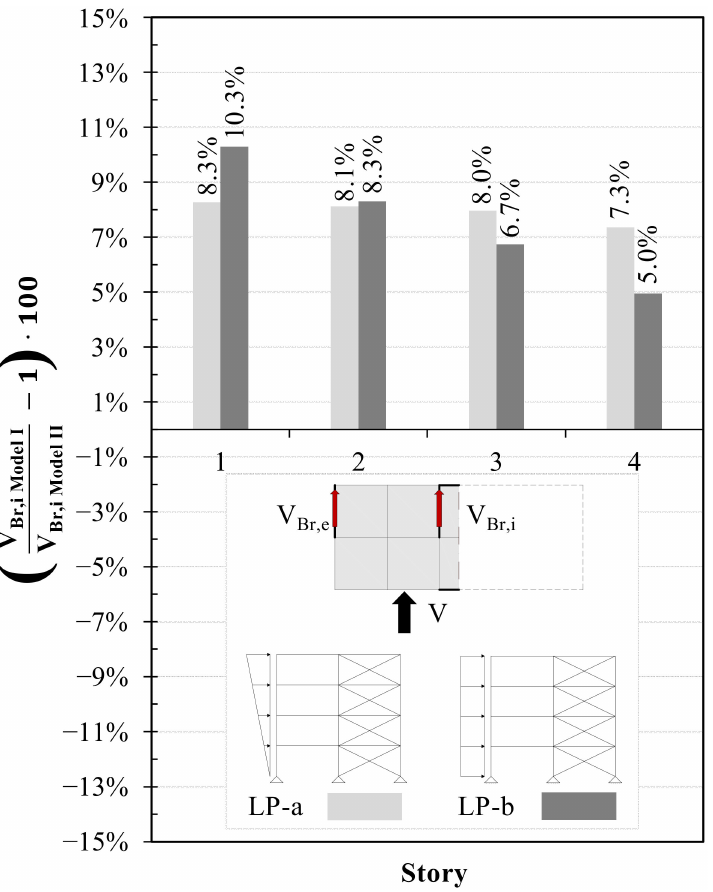
Figure 8. Shear forces distribution under a NC design load for LP-a and